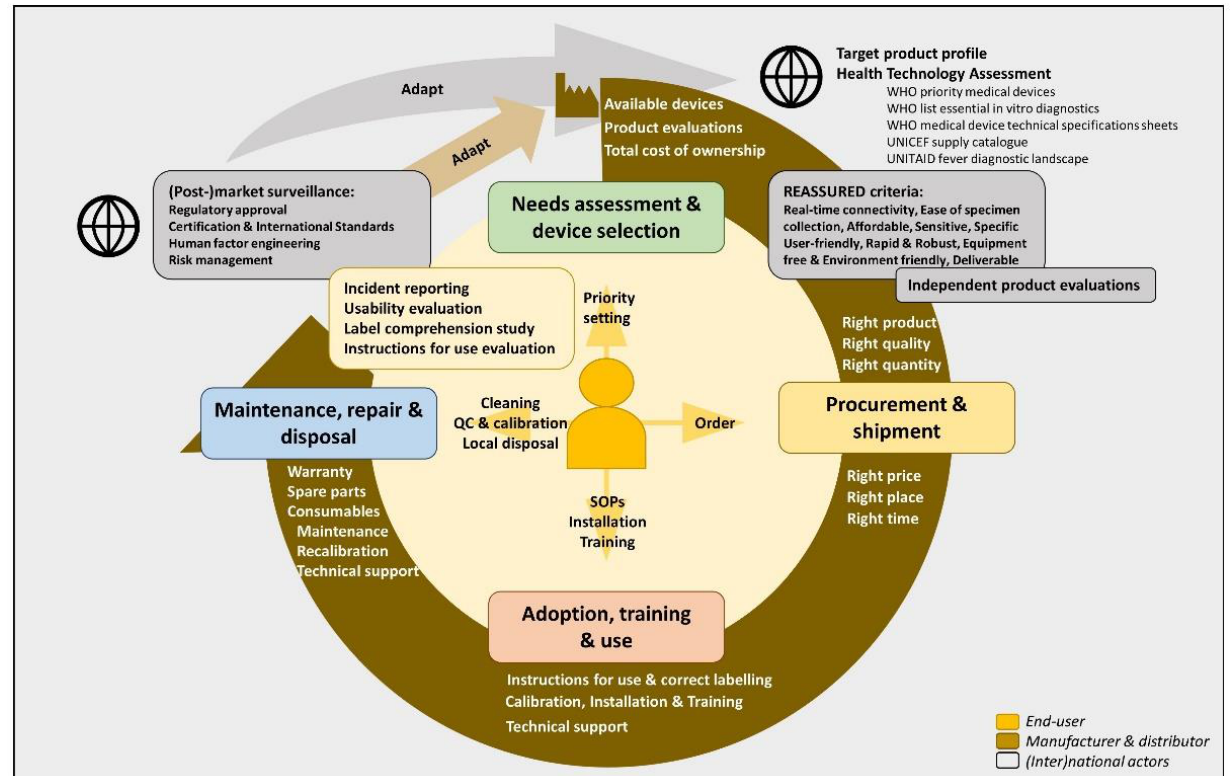
Figure 1. Life cycle of a diagnostic device at the end-user’s level as described by WHO. At the end-user level, it starts with selection of the diagnostic device based on a needs assessment.